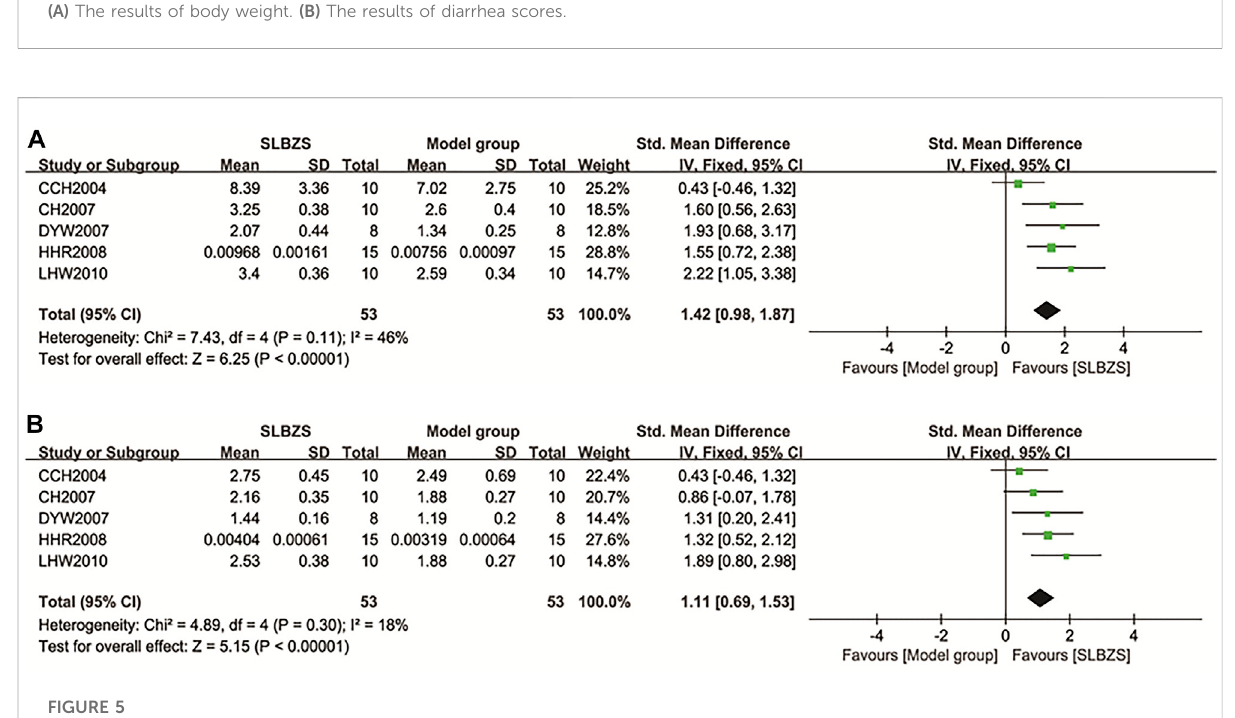
FIGURE 5 (A) The results of spleen index. (B) The results of thymus